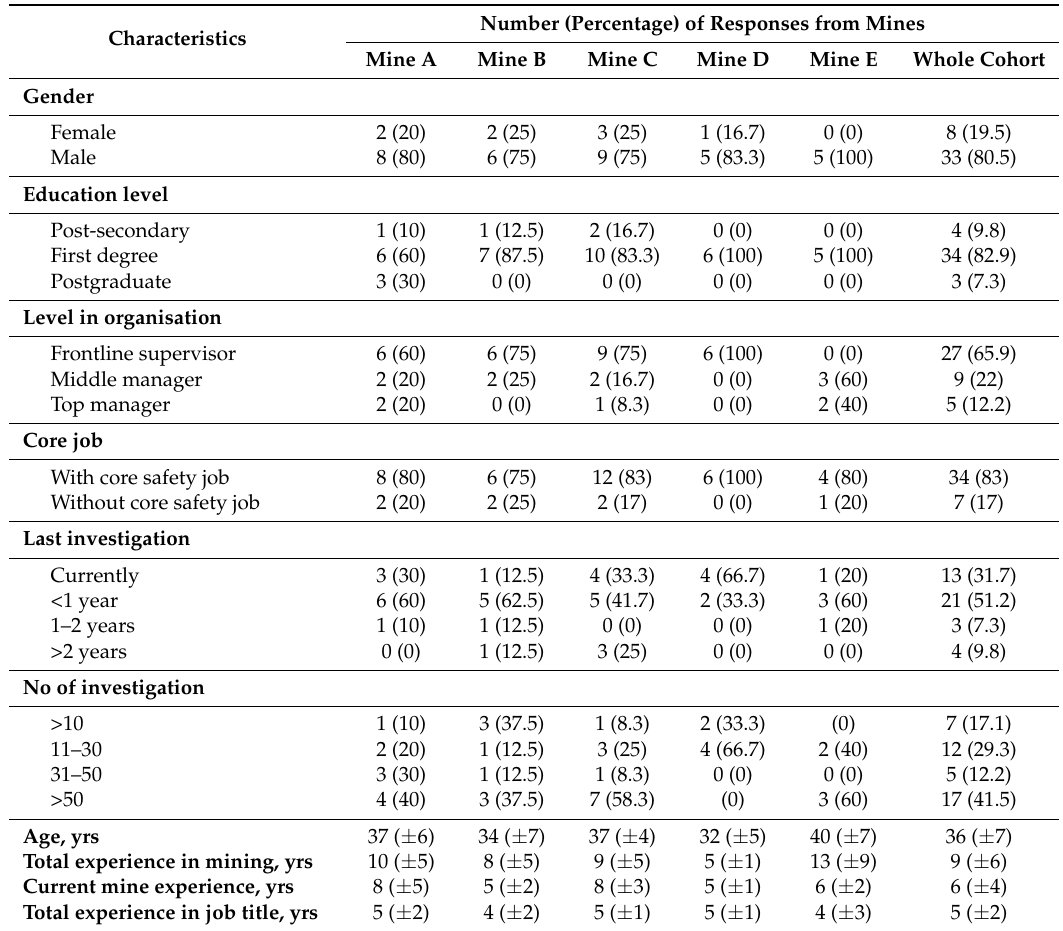
Table 3. Characteristics of interview